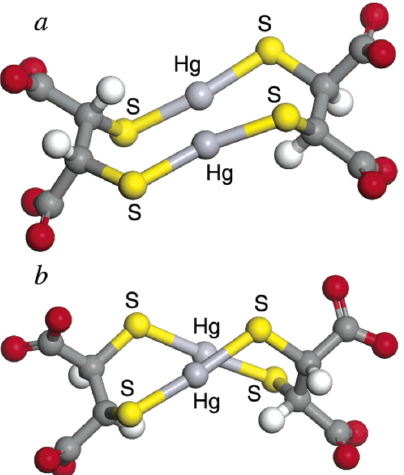
Figure 9. Calculated structures of the two diastereomers of the smallest possible DMSA:Hg 2+ complex. The carbon atoms are depicted as dark gray, oxygen atoms as red, hydrogen atoms as white, mercury atoms as light gray, and sulfur atoms as yellow. Reproduced from reference [144].